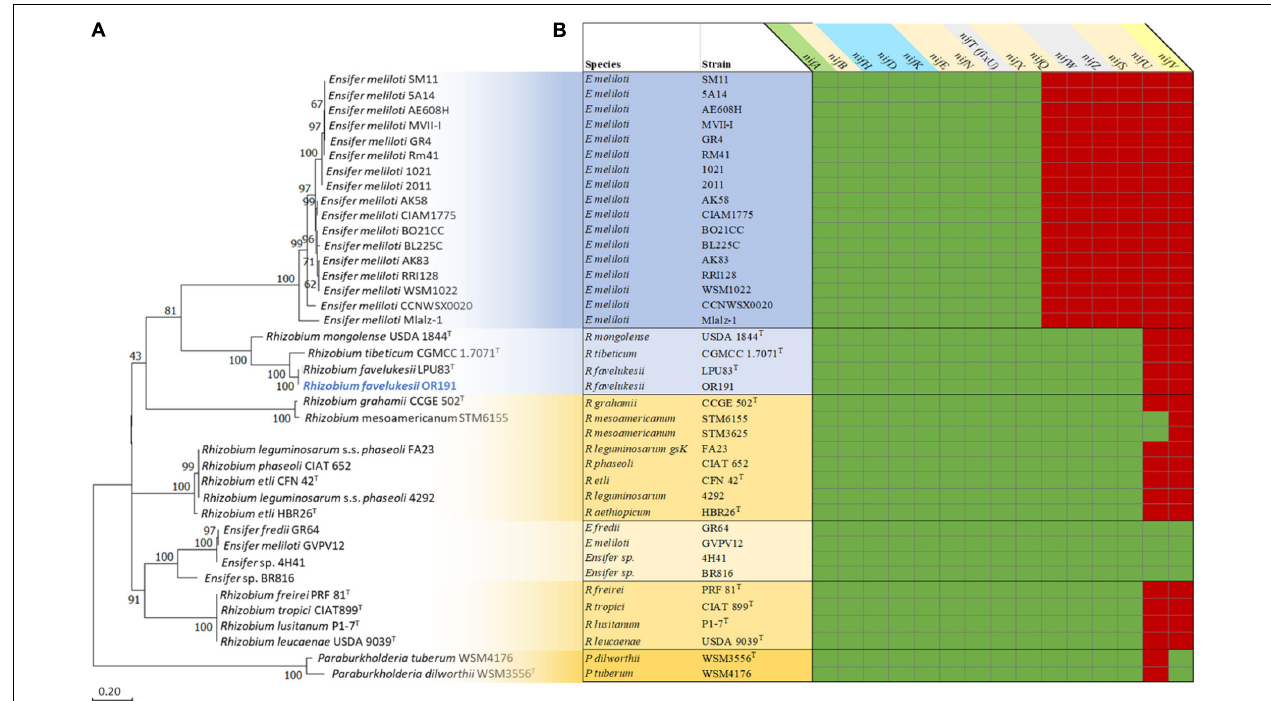
FIGURE 2 | Analysis of the nitrogen fixation genes and proteins in Medicago and Phaseolus vulgaris microsymbionts ( Supplementary Table 4 ). Phylogenetic analysis of the NifH proteins (A) and a map of nif genes present (green) or absent (red) in the genomes of the microsymbionts (B) . All microsymbionts shaded in blue nodulate and fix with Medicago sp. Strains shaded in yellow nodulate and fix with Phaseolus vulgaris . Rhizobium favelukesii LPU83, Rhizobium mongolense USDA 1844, Rhizobium tibeticum CGMCC 1.7071 can nodulate both Medicago spp. and Phaseolus vulgaris .